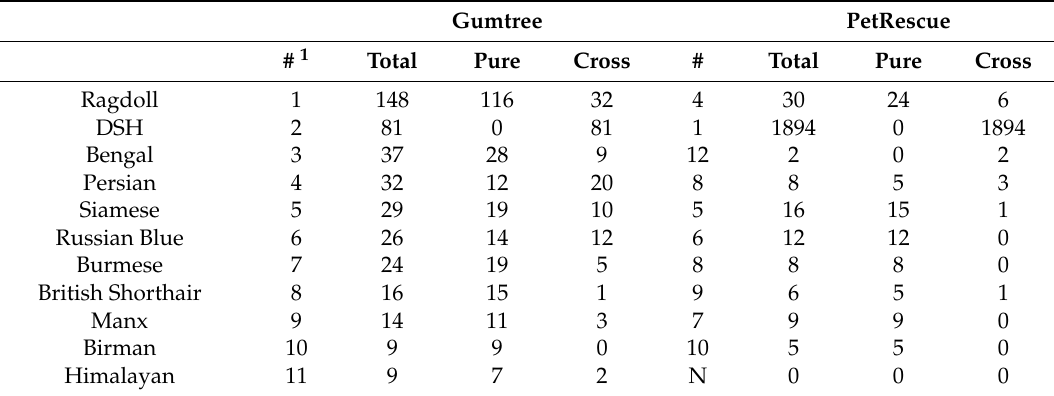
Table 4. Cat breeds relinquished on Gumtree from 9 to 26 February 2016 in comparison to those advertised in the same period on